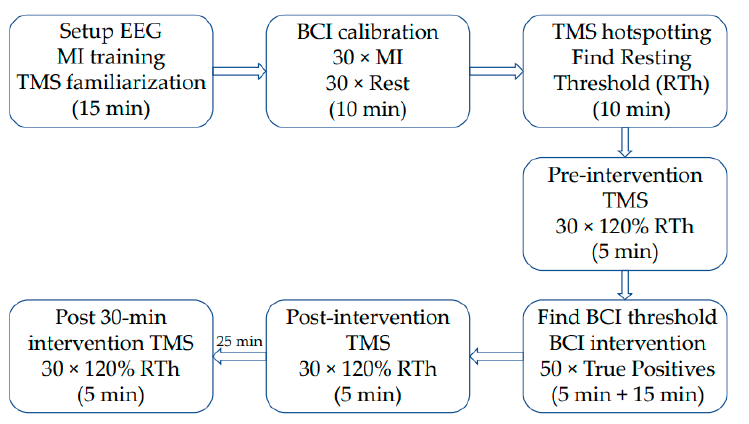
Figure 11. Timeline of the experiment [102].